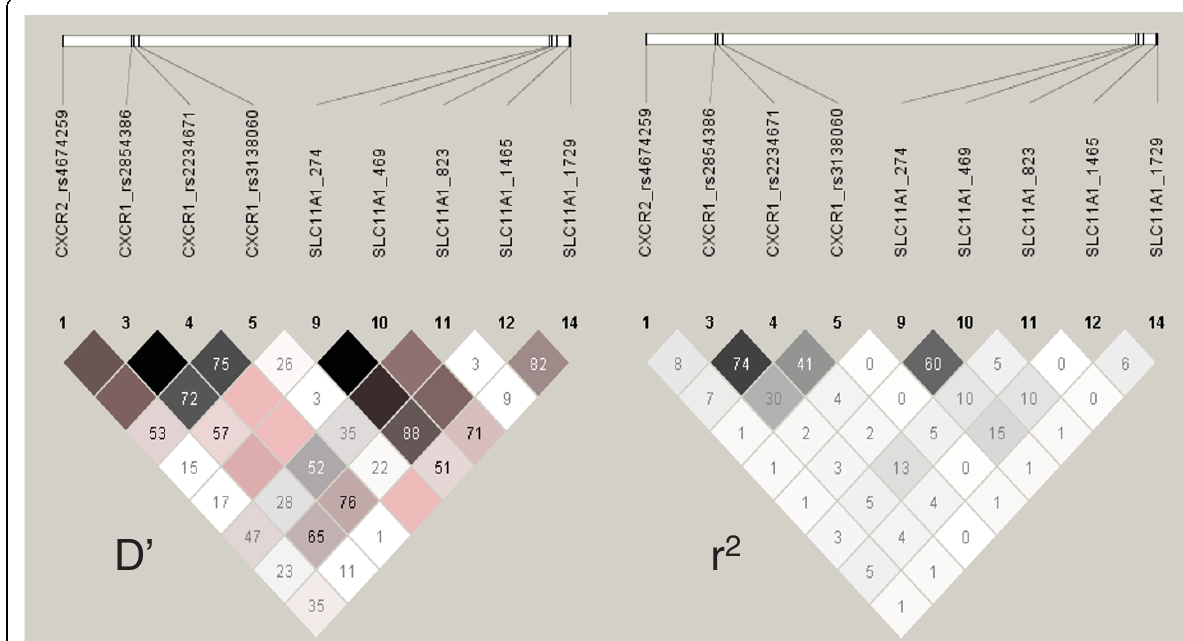
Figure 1 Haploview analysis for D ’ and r 2 pairwise measures of LD between CXCR2, CXCR1 and SLC11A1 SNPs and IN/DEL in family founders from the study population in Brazil . D ’ values and confidence levels (LOD) are represented as black for D ’ = 1, LOD>2; shades of pink for high D ’ , LOD<2; white for D ’ <1, LOD<2. r 2 values are represented as black for r 2 = 1, white for r 2 = 0, with intermediate values for 0<r 2 < 1 indicated by shades of grey. The numbers within the squares represent the D ’ or r 2 scores for pairwise